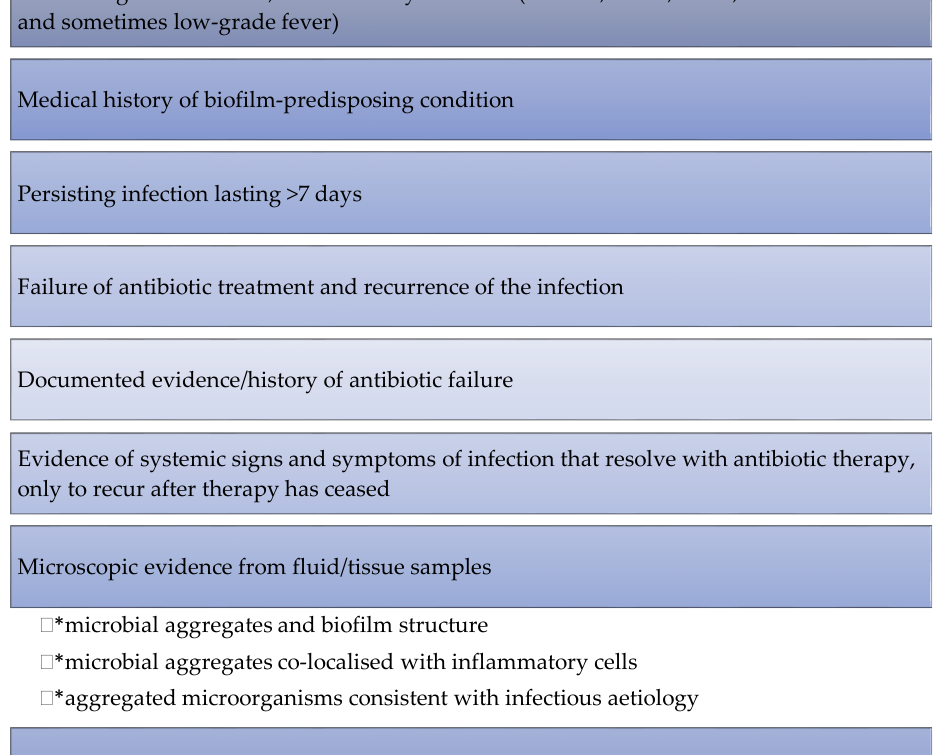
Figure 1. Clinical and laboratory indications for diagnosis of biofilm infections—ESCMID General Features. Based on Høiby et al. [124].